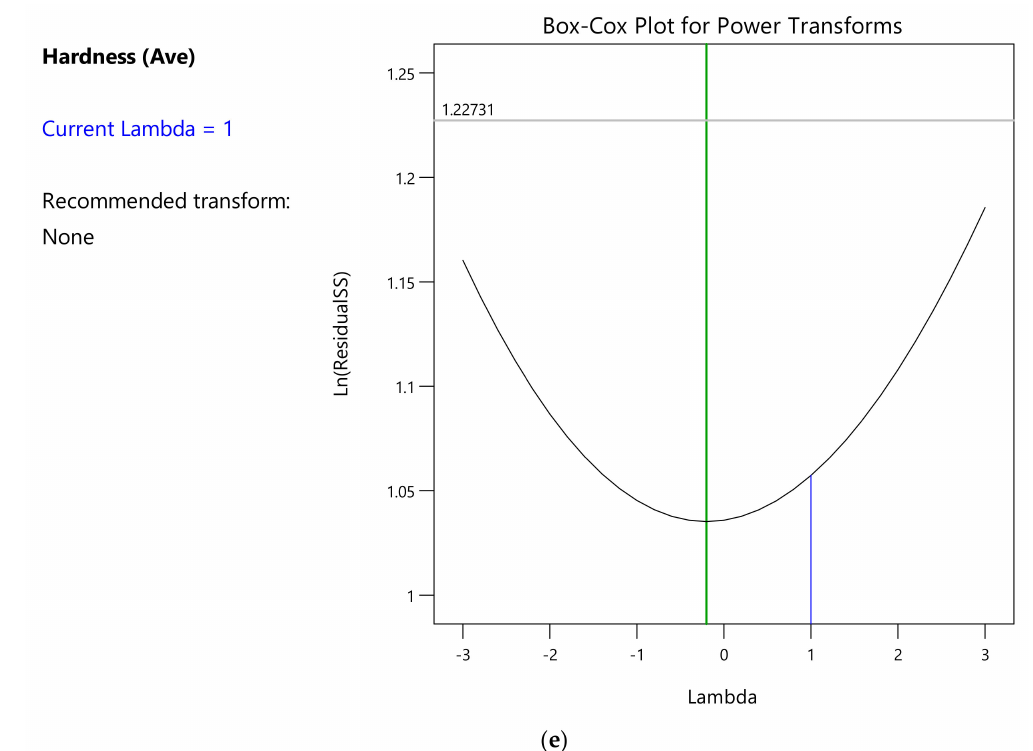
Figure A4. Statistical quality assertion: ( a ) Half-Normal plot vs. Externally studentized residuals for random error check, ( b ) Residuals vs. predicted value for independent residuals, ( c ) Residual vs. run for the absence of variation from printing location, ( d ) Cook’s distance plot for identification of outliers and ( e ) Box-Cox plot to identify any need of a transformation of the